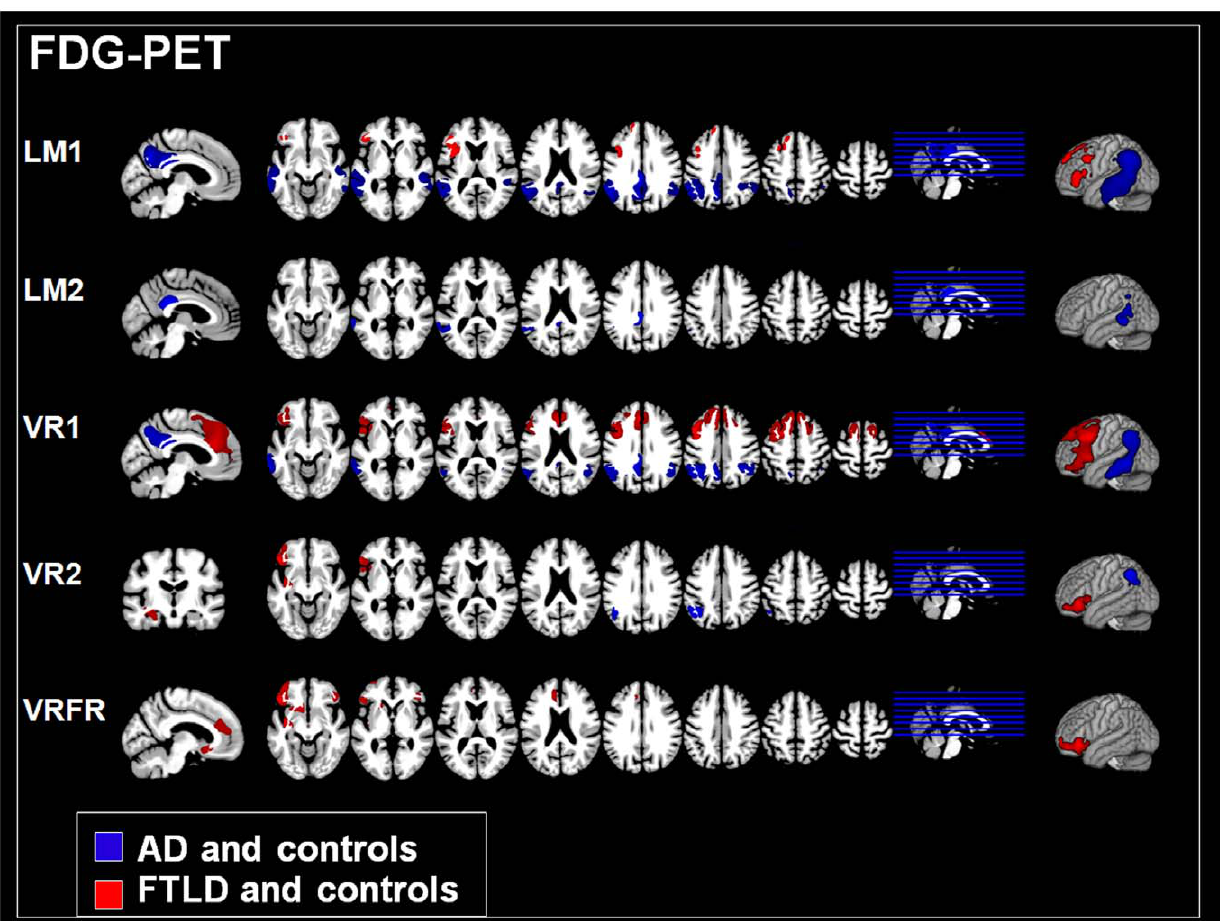
Figure 2. Memory performance and hypometabolism. Correlations between hypometabolism (FDG-PET) and each memory measure for AD patients and controls (blue) as well as FTLD patients and controls (red). LM: WMS Logical Memory , VR: WMS Visual Reproduction , 1: immediate recall, 2: delayed recall, FR: Forgetting rate. Results are only reported for those memory measures for which significant correlations in any region were found. Only clusters are shown that exceeded a significance threshold of p , 0.001 uncorrected at voxel level and a cluster threshold of 2000 voxels. Left is left.